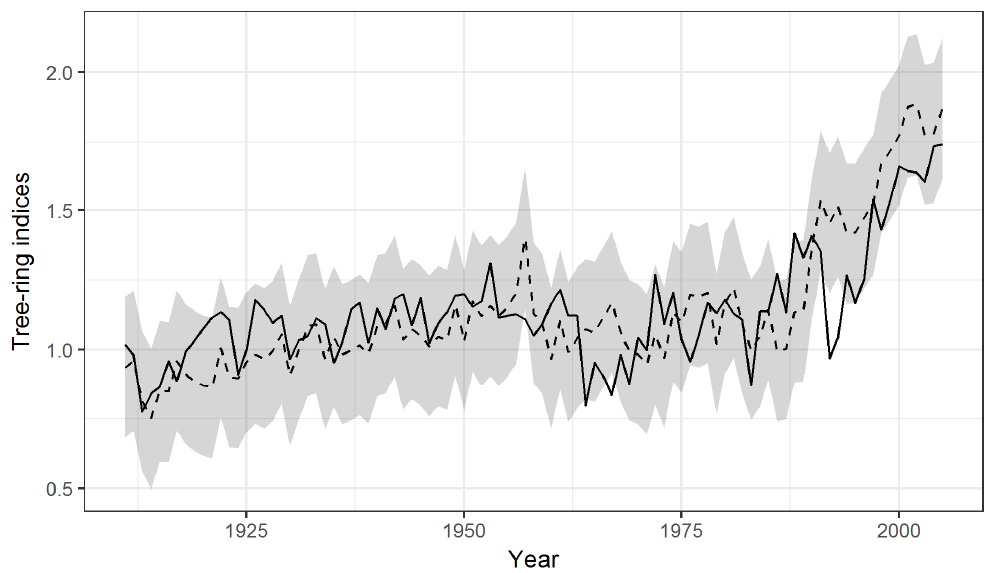
Figure 8. Comparison of the projected (dashed line) and actual (solid line) tree ‐ ring chronology for the common period 1911–2005. Grey area indicates the uncertainty (±1 root mean squared error) in the projected climate ‐ induced tree growth. Table 3. Statistic of split sample calibration ‐ verification test. R: correlation coefficient; R 2 : the proportion of variance explained by the regression model; RE: reduction of error; CE: coefficient of efficiency.